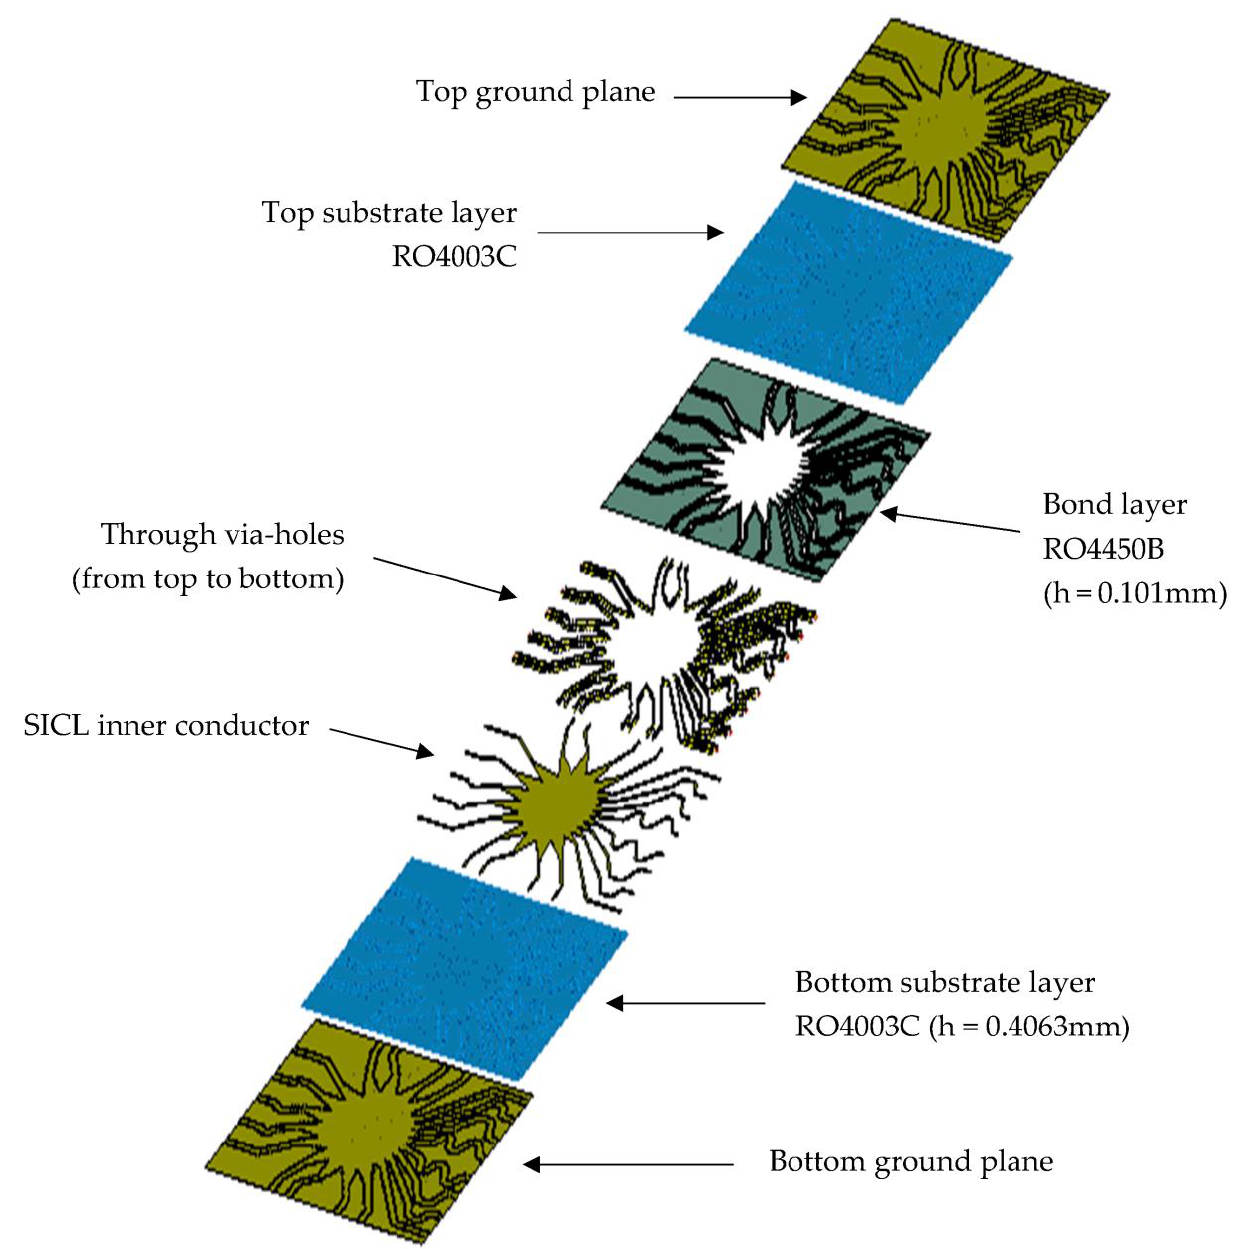
Figure 4. Layer layout view of the designed SICL Rotman Lens. In the SICL, the design is sandwiched between two substrate layers which significantly improves the reflection coefficients (at some frequencies up to 15 dB) at the input ports. The simulated insertion losses of the designed RL are compared in Figure 5. Using the SICL, the insertion losses are improved by up to 5 dB as compared with the design of the MSL RL, which means a good transmission of EM energy from the input beam ports to the output array ports. A progressive phase shift is achieved at the output array ports when input beam ports are excited sequentially as can be seen in Figure 6. It can be seen that due to the phase alignment of the transmission lines connecting the connectors to the RL structure, the designed SICL RL shows a phase-aligned distribution across the output array